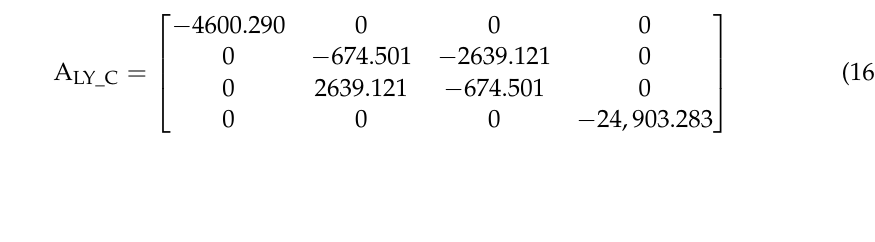
On the other hand, the controllers for LRAMB along the X-axis and along the Y-axis are to levitate the lower part of the rotor together; the characteristics of the controller for LRAMB along the Y-axis are similar to those of the controller for LRAMB along the X-axis. The Bode plot of the controller for LRAMB along the Y-axis is close to that of the controller for LRAMB along the X-axis. The identified models of the controller for LRAMB along the Y-axis